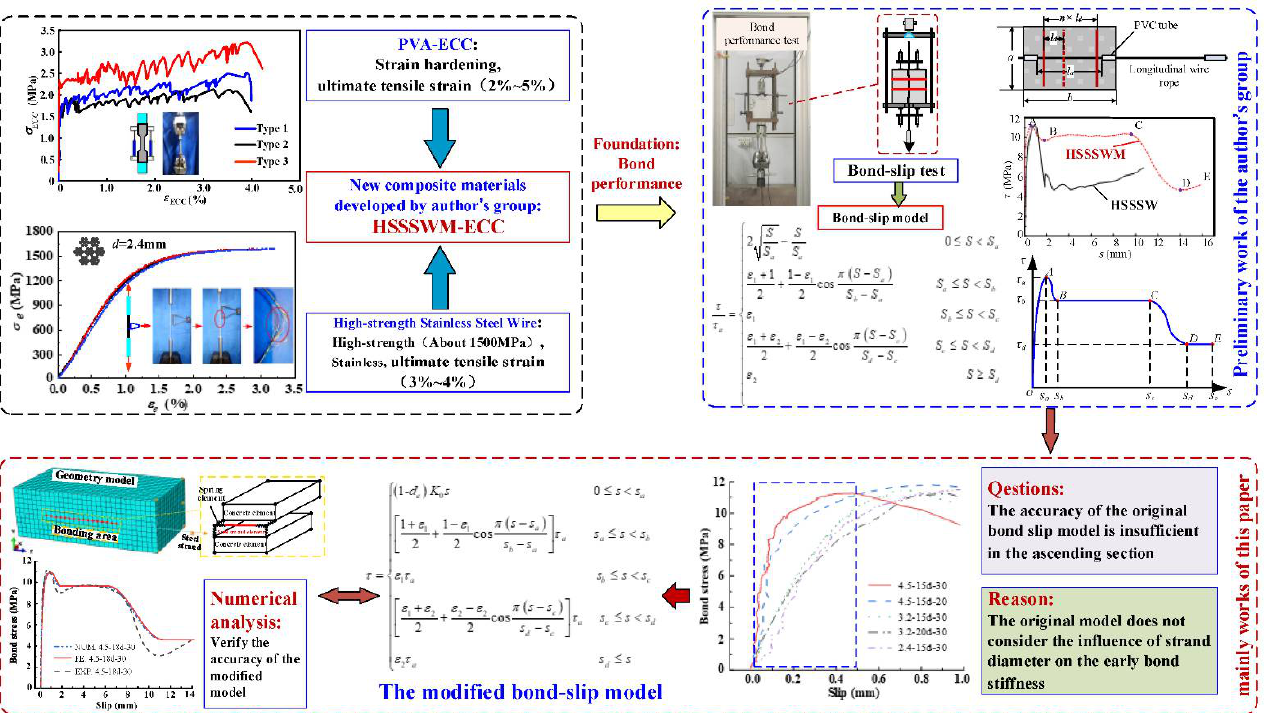
Figure 1. The workflow